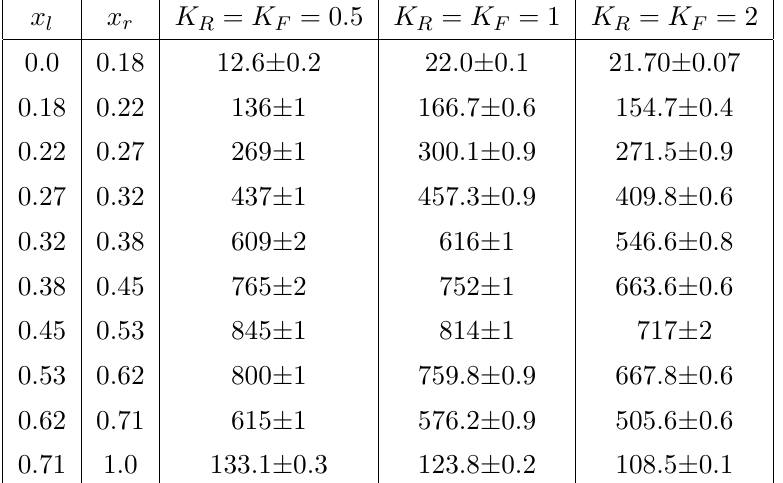
Table 3 . NLO predictions for the ρ s distribution [pb] for t ¯ tj + X hadroproduction at using as input the CT18 NLO central PDF set, m t = 172 GeV and µ 0 = m t , for N j ≥ 1 , p j 30 GeV, | η j | < 2 . 4 . See section 3 for more detail.